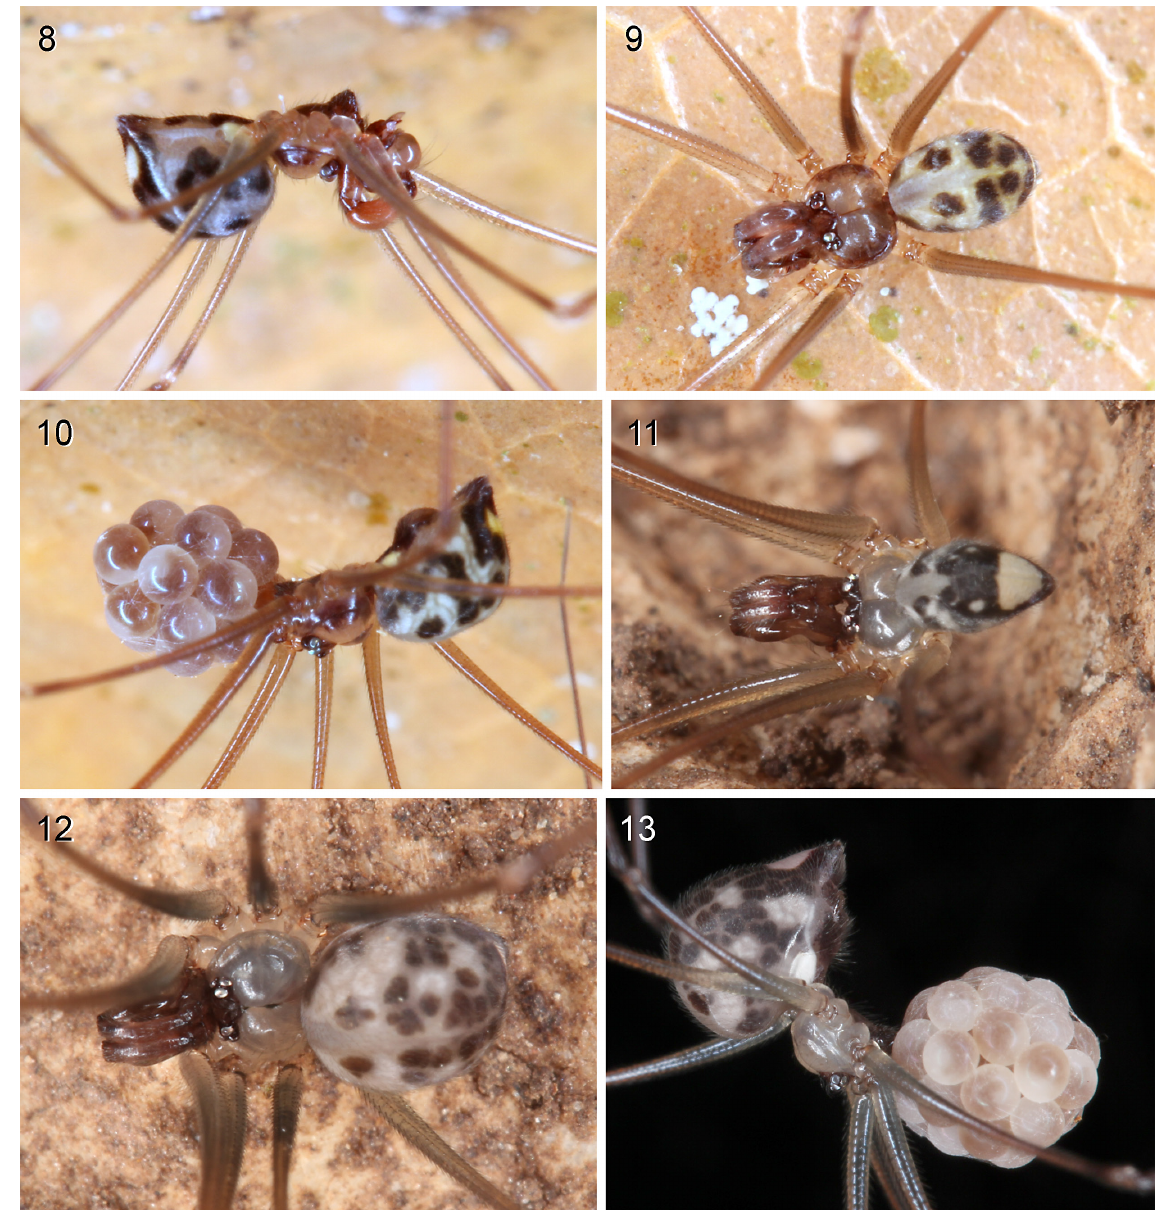
Figs 8–13. Live specimens. — 8–10 . Savarna thaleban Huber, 2005. ♂♂ and ♀ with eggsac; all from Thaleban National Park. — 11–13 . S. tessellata (Simon, 1901). ♂♂ and ♀ with eggsac; all from Tham